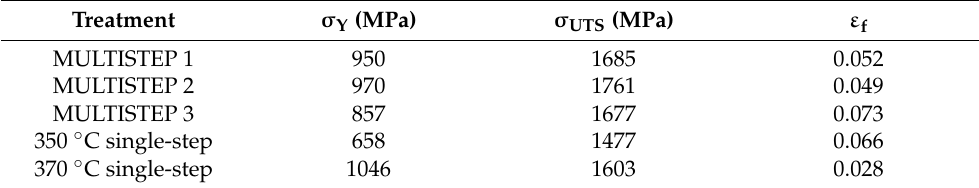
Figure 10. Engineering stress–engineering strain curves of the heat-treated steel samples (yield strength was calculated with the 0.2 criteria). Table 6. Resume of mechanical properties of the heat-treated steel samples.